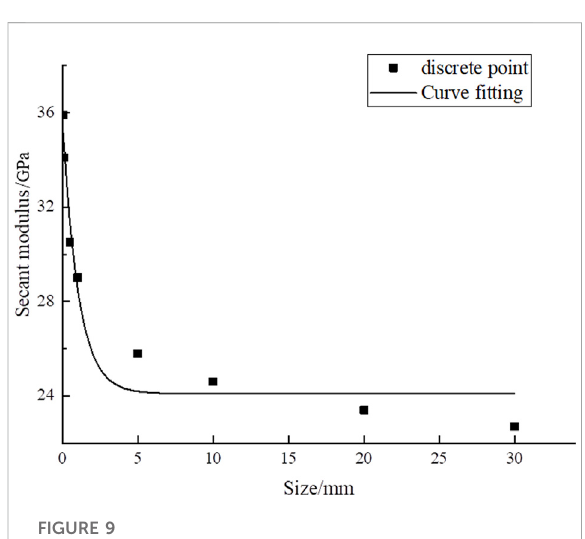
FIGURE 9 Fitting curves of the secant modulus with